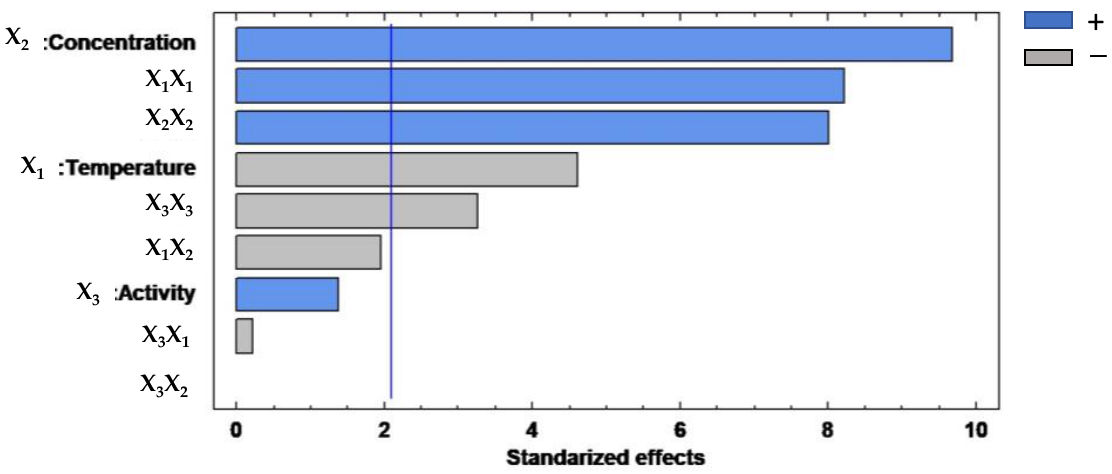
Figure 2. Pareto diagram of the standardized effects of the esterification conversion of HMF and lauric acid in acetone catalyzed by the Novozym 435 ® biocatalyst, where x 1 : temperature; x 2 : concentration of HMF; x 3 : activity of Novozym 435 ® .